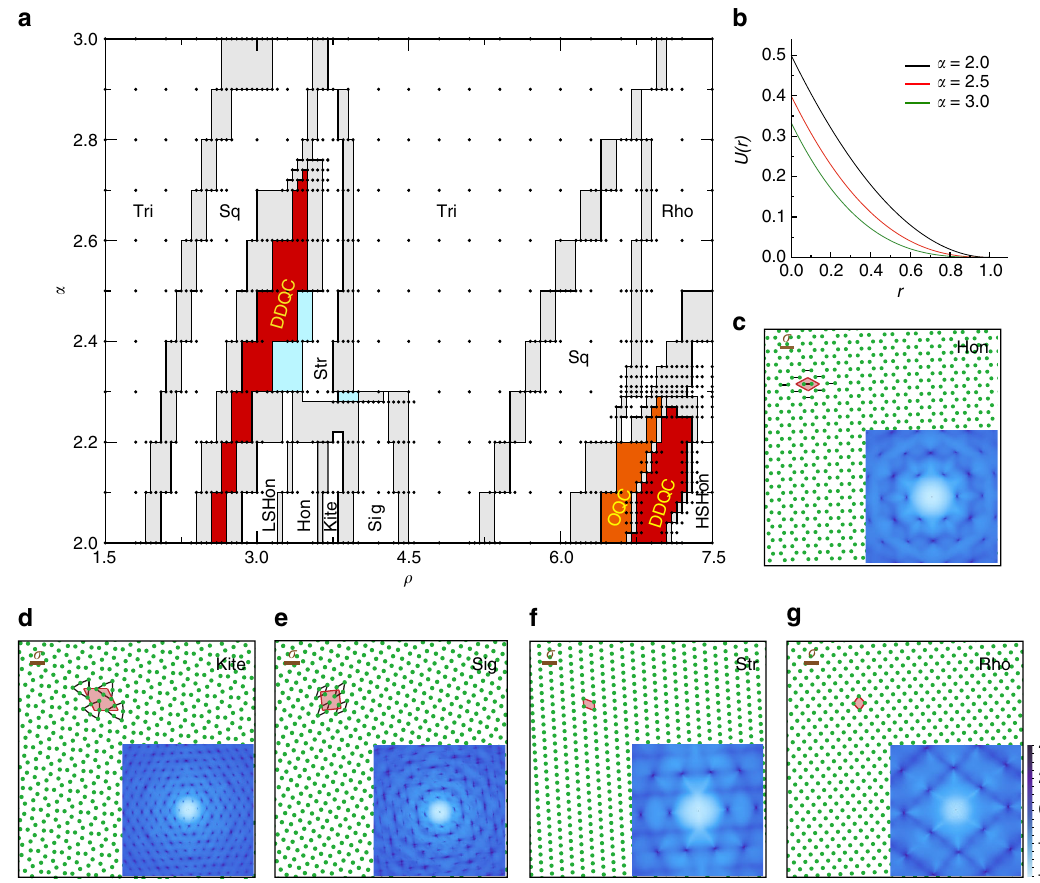
Fig. 1 Multiple solid phases formed by soft-core particles at high densities. a Phase diagram of solid states in terms of number density ρ and potential exponent α at a fi xed temperature T = 10 − 4 . The black dots label the ( ρ , α ) pairs where we run simulations to identify states. The orange and red areas are the territories of OQCs and DDQCs, respectively. The gray and light-blue areas are phase coexistence regimes of two and three types of solids, respectively. In addition to the abbreviations de fi ned in the text, LSHon and HSHon denote lower- and higher-density stretched honeycomb, respectively. b Examples of particle interaction potentials with different α . c – g A part of static con fi gurations of fi ve distinct crystalline solids with the scale bar indicating the actual size of particle diameter σ . The ( ρ , α ) values of the fi ve states are (3.35, 2.0), (3.70, 2.0), (3.95, 2.0), (3.60, 2.3), and (6.90, 2.4), respectively. The red-shaded polygons and black lines outline the unit cell and basis, respectively. The insets are diffraction patterns with the values of the scale bar being in the logarithmic